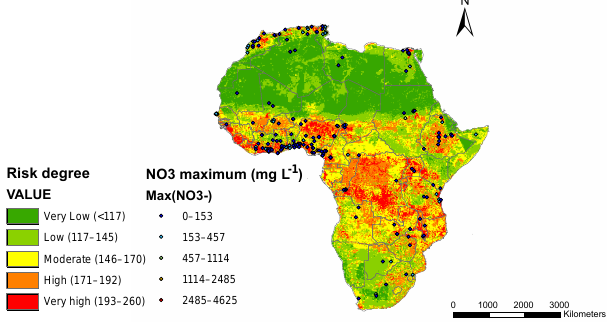
Figure 3. The locations and the maximum values of nitrate in Africa superimposed on a risk pollution map as generated in the previous generic vulnerability study of Ouedraogo et al.